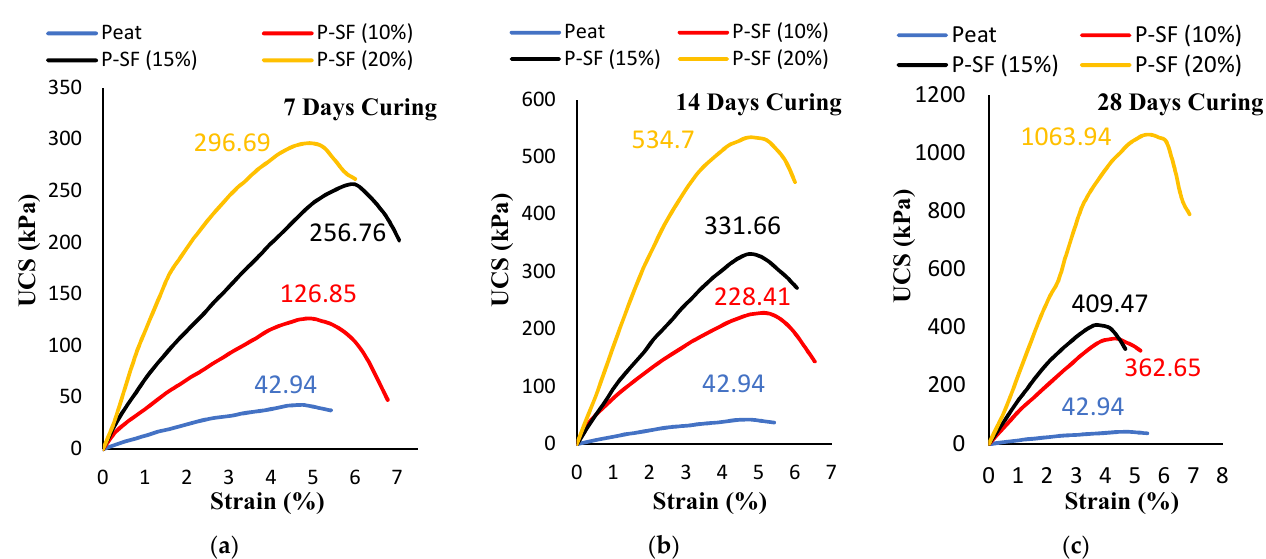
Figure 3. The unconfined compression strength of 10%, 15%, and 20% SF-stabilized peat under varying curing periods: ( a ) 7 days, ( b ) 14 days, and ( c ) 28 days.